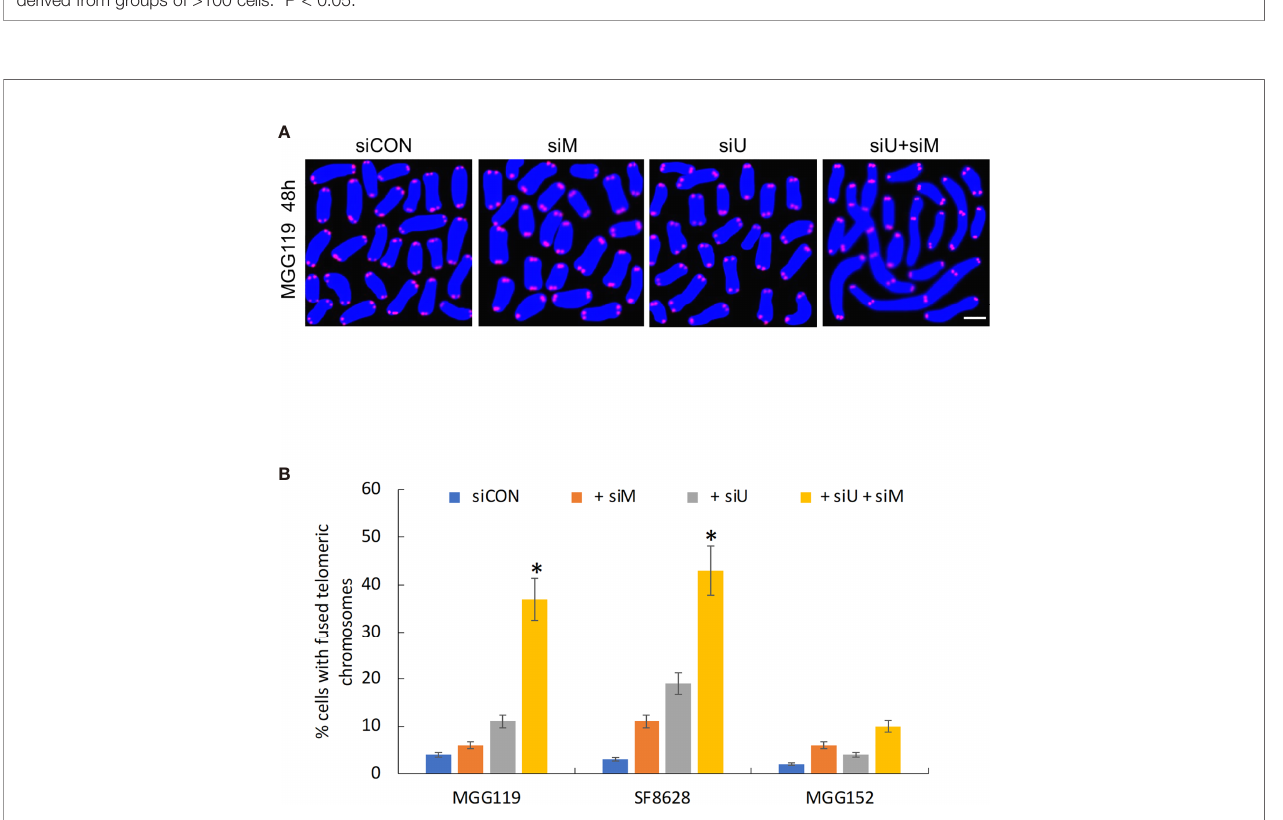
FIGURE 3 | (A) Representative image of MGG119 cells after 48 hours exposure to scrambled siRNA control (siCON) or pooled siRNA targeting MRE11 (siM), UBR5 (siU) or both. Scale bar, 10 m m. DAPI is blue and telomere-speci fi c probe is red. Scale bar, 10 m m. (B) Percentage of cells with >1 telomere-fused chromosome in metaphase spreads 48 hours after the indicated siRNA exposure. Signi fi cance relative to nontargeted (siCON) are indicated. *P <